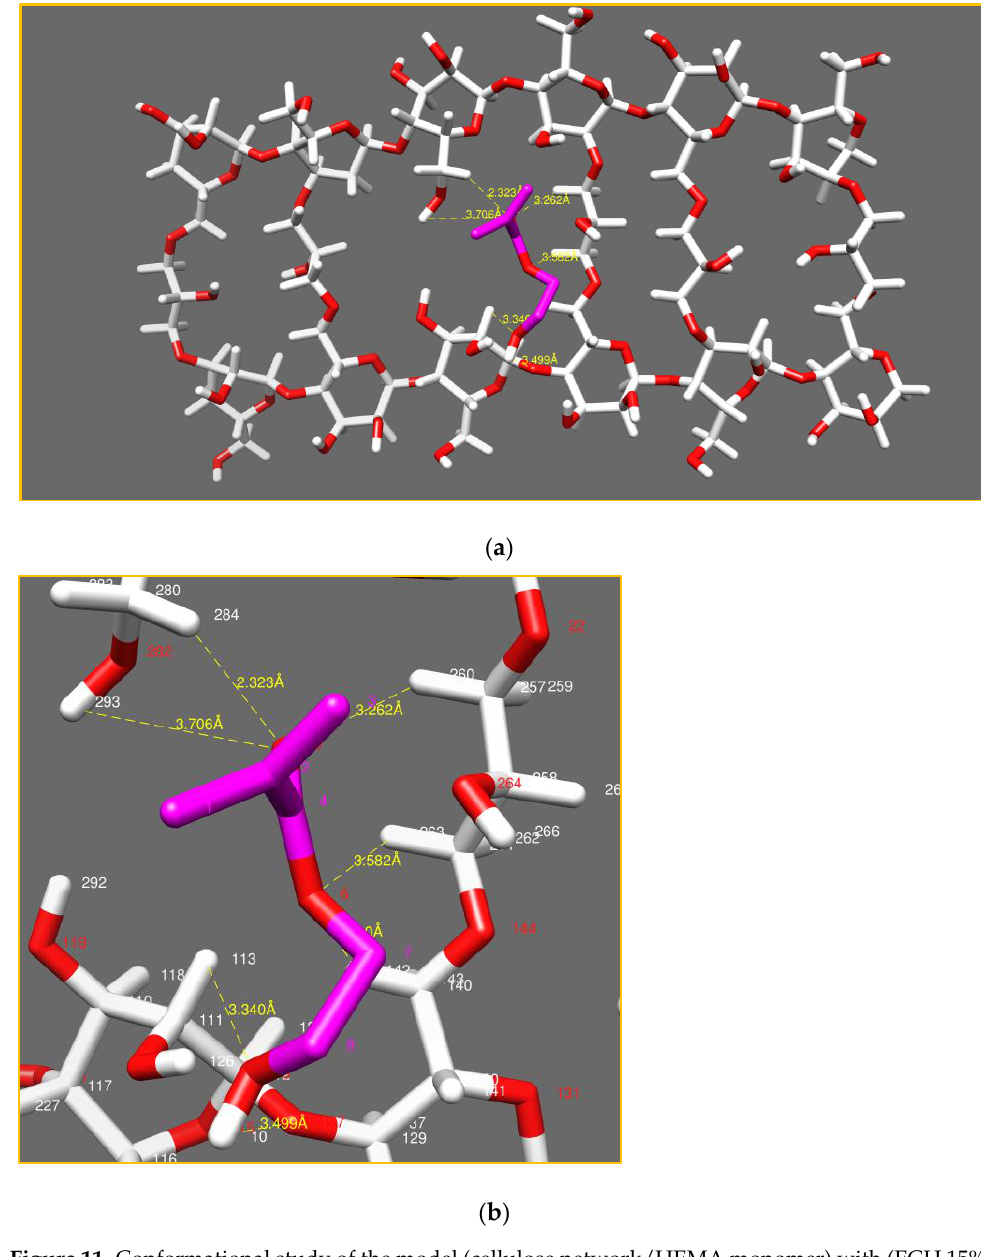
Figure 11. Conformational study of the model (cellulose network/HEMA monomer) with (ECH 15%) ( a ). Aggrandizement of interactions ( b ).